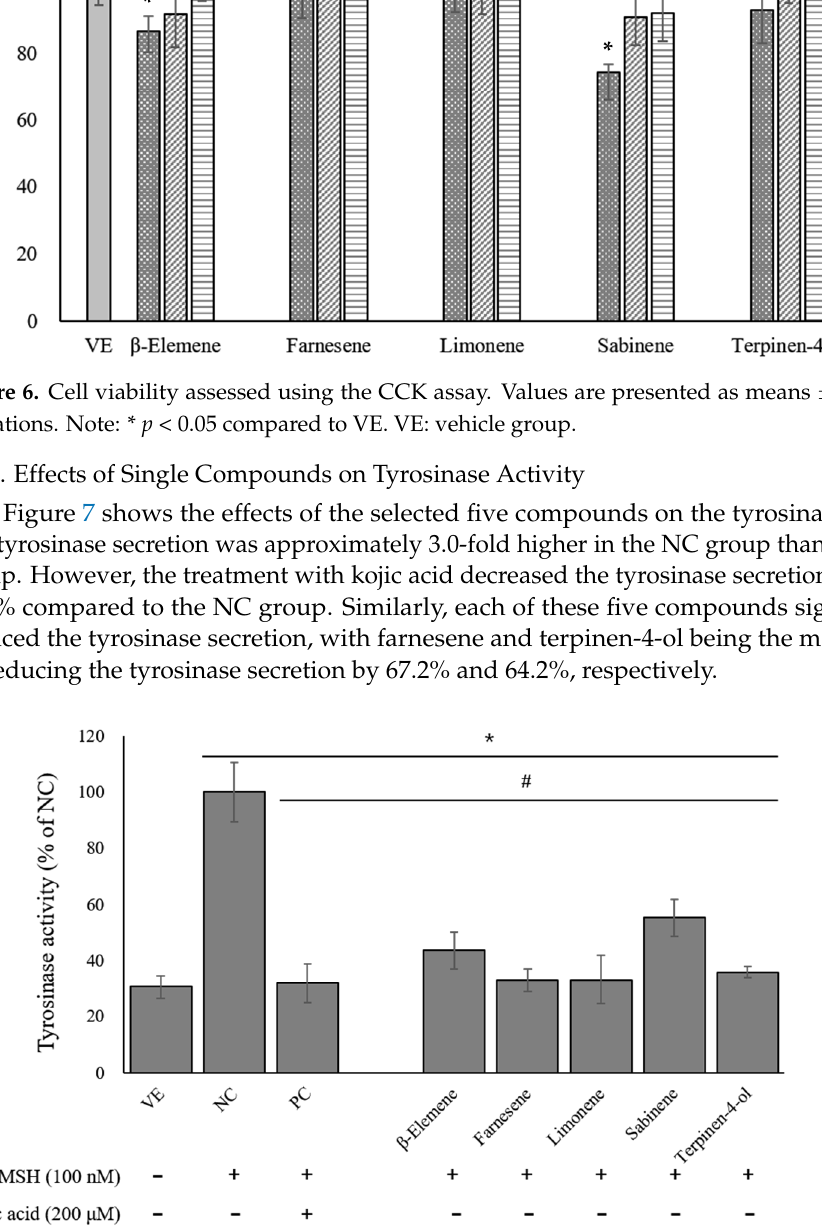
Figure 7. Effects of single compounds on tyrosinase activity. Values are presented as means ± standard deviations. Note: * p < 0.05 compared to VE; # p < 0.05 compared to NC. VE, vehicle group; NC, 100 nM α -MSH; PC, 200 µ M kojic